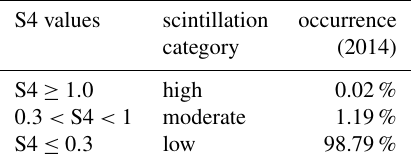
Table 1. Categorization of S4 index